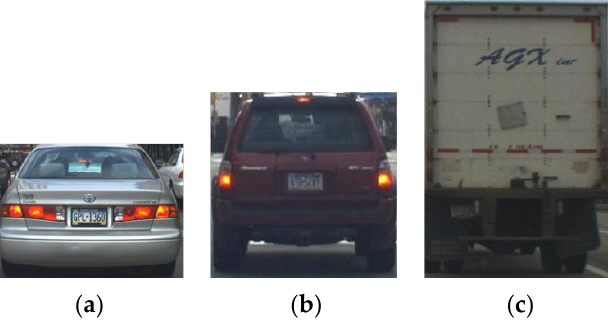
Figure 2. Vehicle images for various vehicle aspect ratios: ( a ) 0.7; ( b ) 1; and ( c ) 1.5.